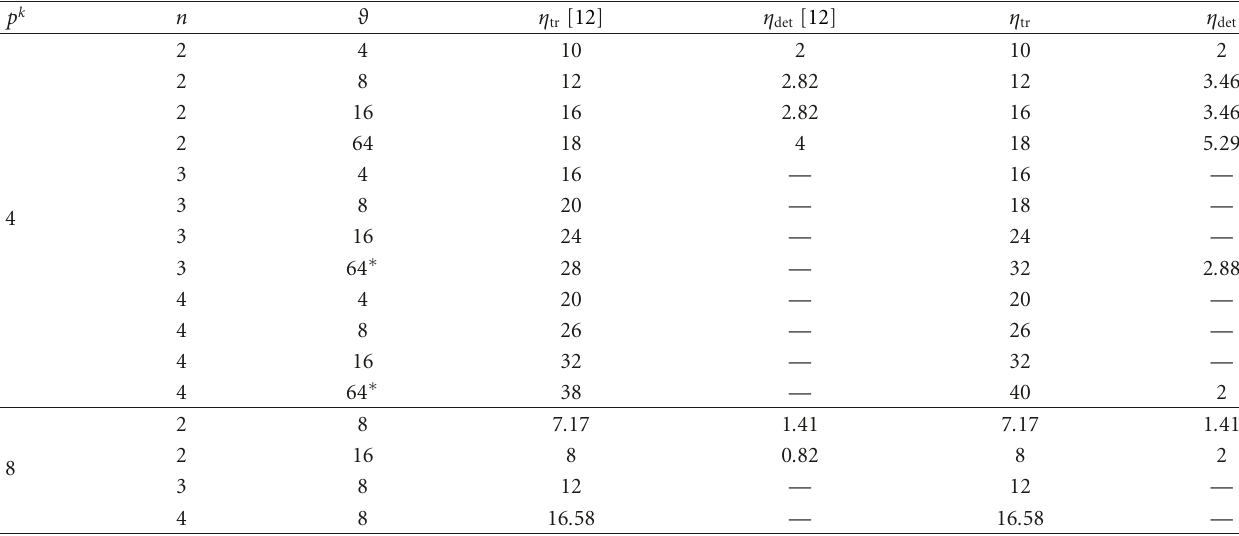
Table 3: Comparison of STCCs found with di ff erent encoder